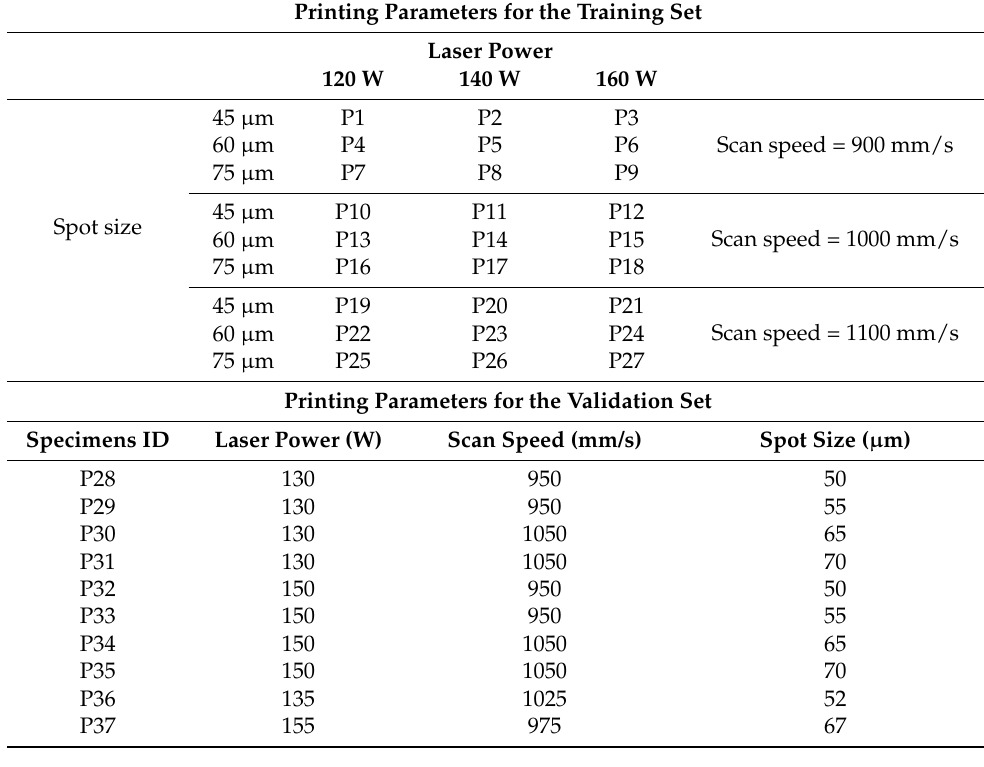
Table 1. Printing parameters of the SLM process for the training and validation set. Printing Parameters for the Training